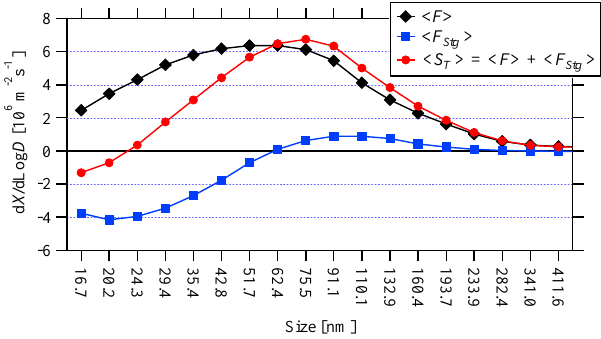
Figure 7. Fluxes and storage rates by bin midpoint size ( D ). The variable X in d X /dLog D 2 Fig. 7. Fluxes and storage rates by bin midpoint size ( D) . The represents average flux, F , storage rate, variable X in dX/d Log D represents average flux, h F i , storage rate, (cid:10) F (cid:11) , or source rate, h S legend. 4 Stg